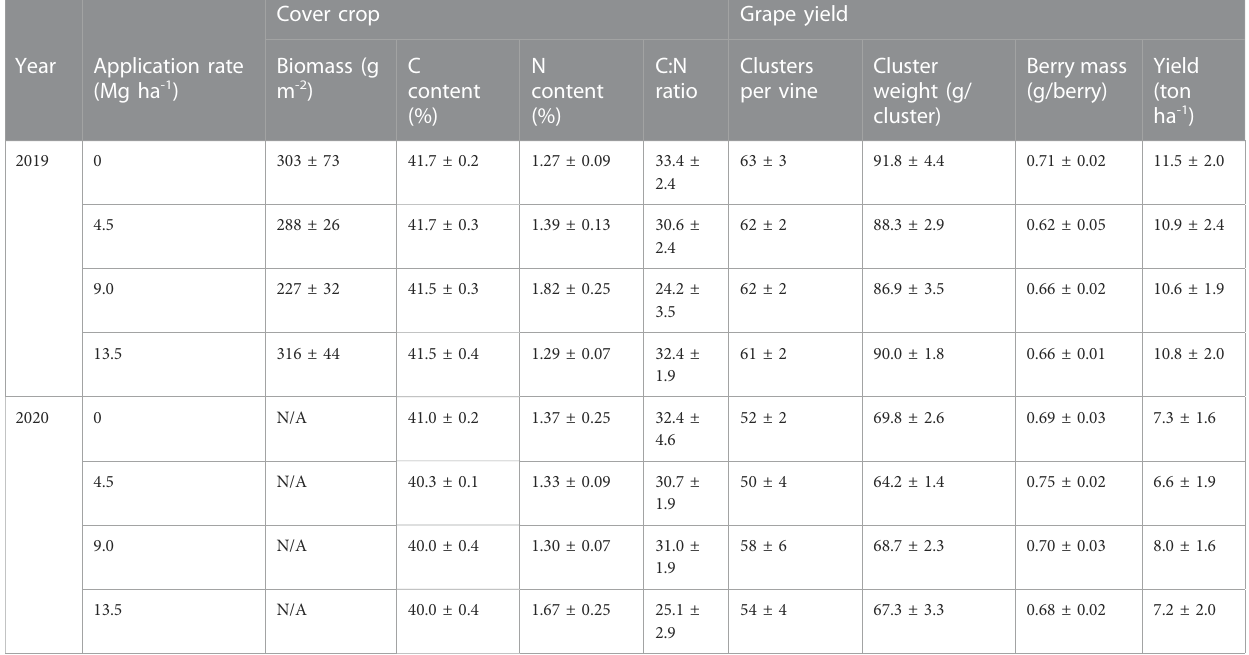
TABLE 6Dry biomass andCcontentof cover crop,grapeyield components,andthe respective standard errorsofthe means (n= 4) bycompostapplication rate in 2019 and 2020. Note that cover crop biomass was only measured in April 2019 after the fi rst compost